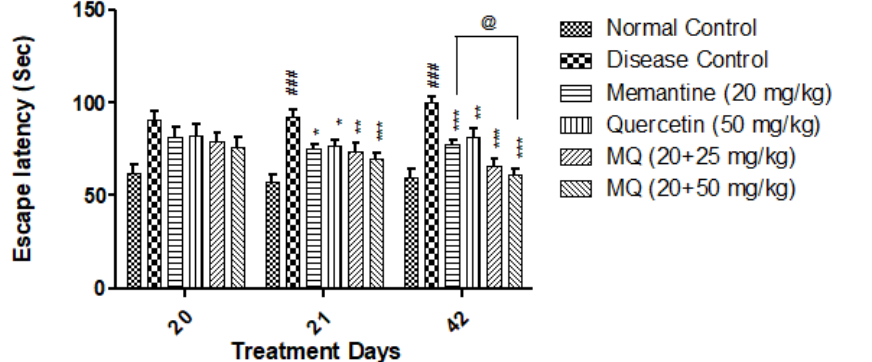
Figure 2. Effect of quercetin and quercetin with memantine on Morris water maze test in AlCl 3 - induced neurotoxicity in rats. Data are expressed as mean ± SEM ( n = 6), ### p < 0.001 when compared with the normal control group, * p < 0.05, ** p < 0.01, *** p < 0.001 when compared with the disease control group, and @ p < 0.05 when compared with the memantine treatment group; AlCl 3 : aluminum chloride; SEM: standard error of mean.